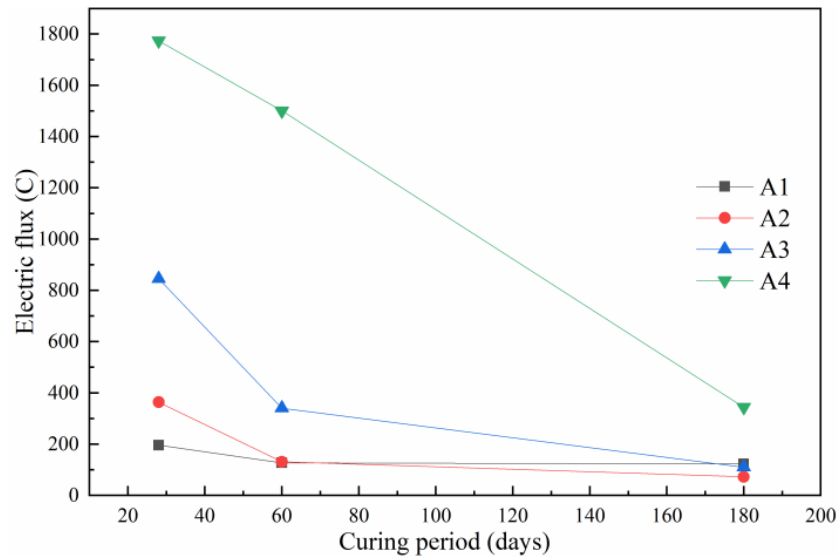
Figure 4. Electric flux of concrete at different ages.